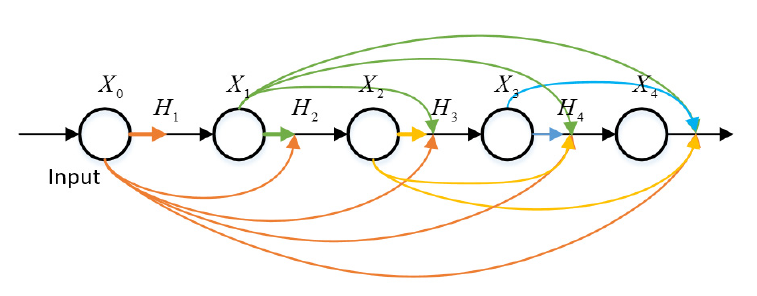
Figure 3. Dense block.